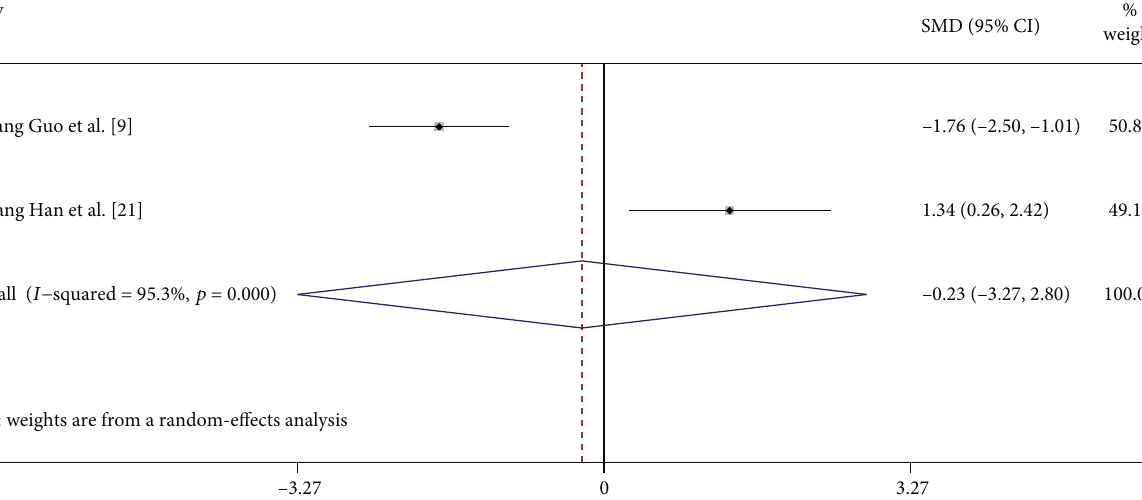
Figure 3: Forest plot of the overall meta-analysis of regulatory T cell (Treg) proportions in peripheral blood (PB), regardless of the Treg de fi nition used, in patients with active and stable